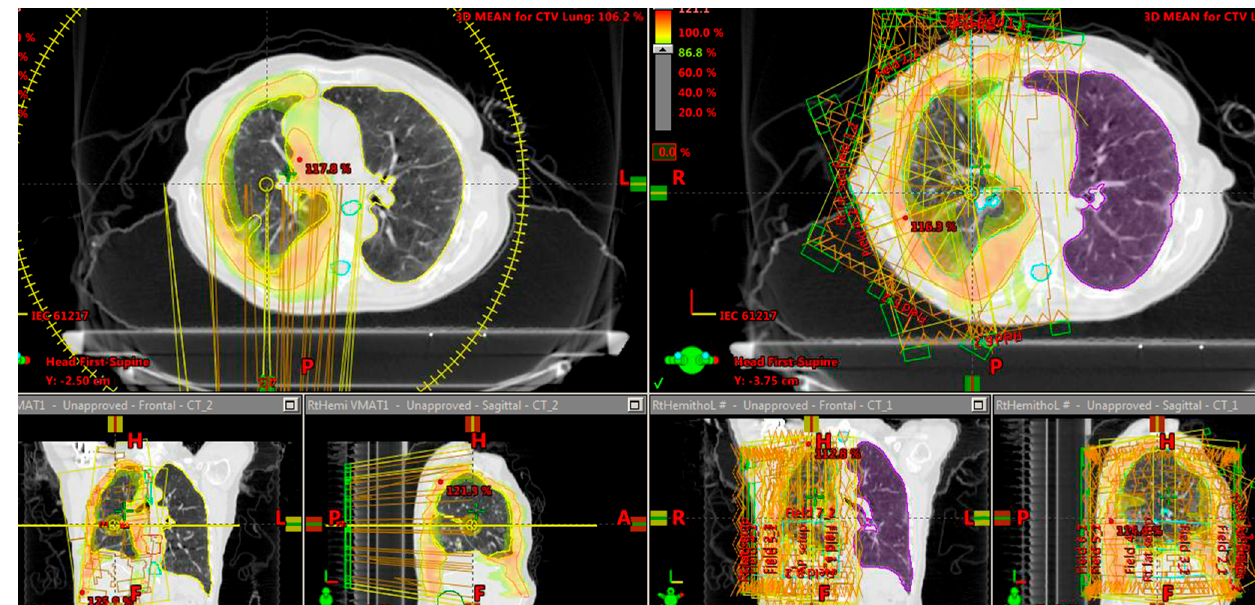
Figure 1. Demonstrates the difference in dose distribution graphically between the two plans. On the left we show axial, coronal and sagittal views of VMAT planning. On the right side the same views with IMRT step and shot planning. In both views the ability to spare the internal lung tissue is seen with slight advantage to VMAT planning.